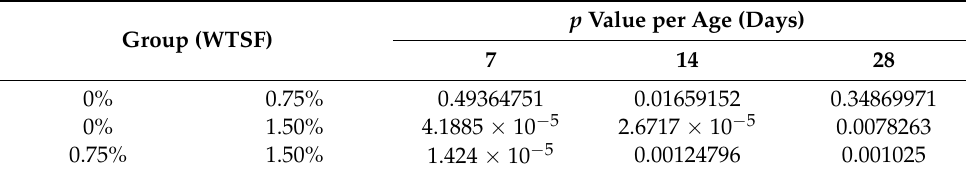
Table 5. Tukey’s test for concrete strength on an aging